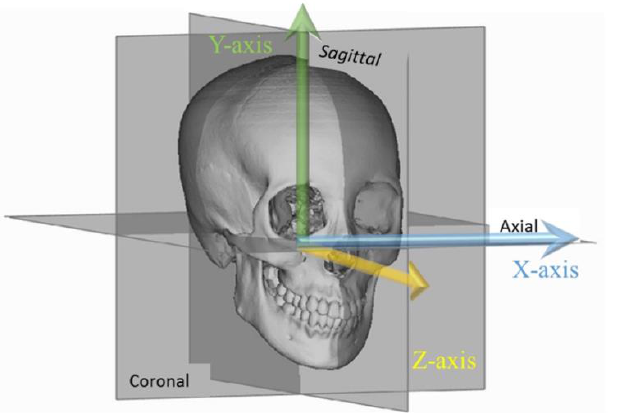
Figure 3. Definition of the coordinate system for the CT image. The X axis was set by the right and left center of porions and orbitales. The Y axis was perpendicular to the X axis and through the right and left porions. The Z axis was perpendicular to the X and Y axes and through the center of the right and left orbitals.